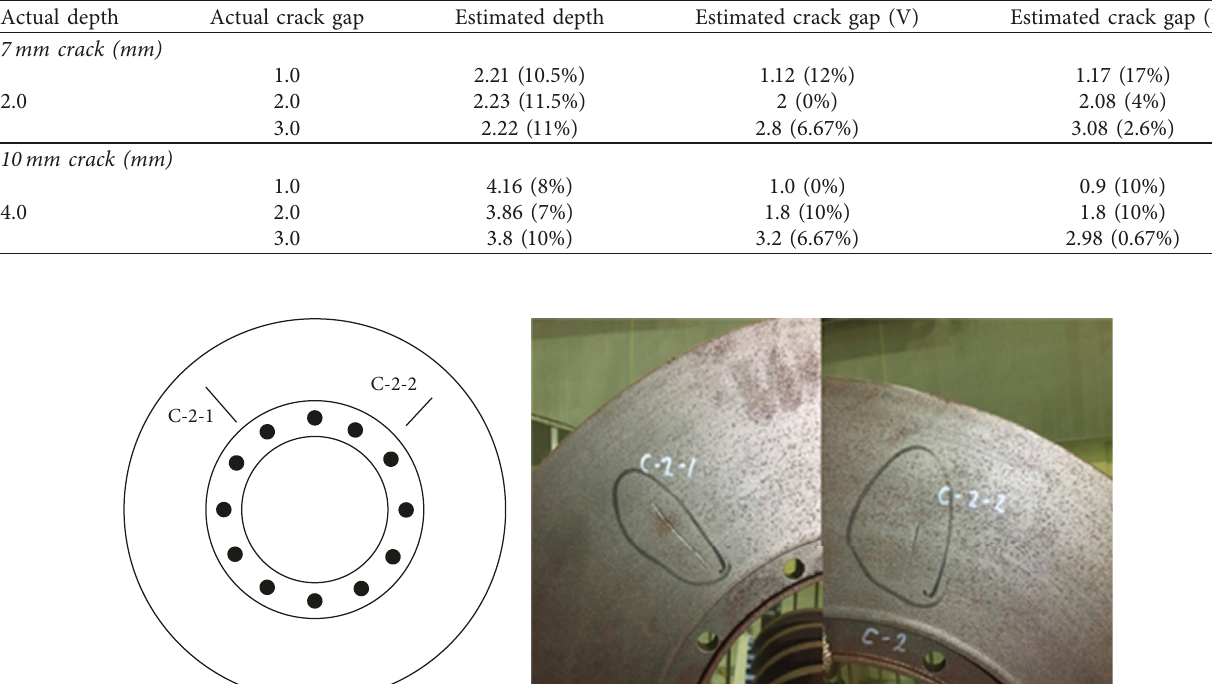
Table 5: Inspection results for triple-type